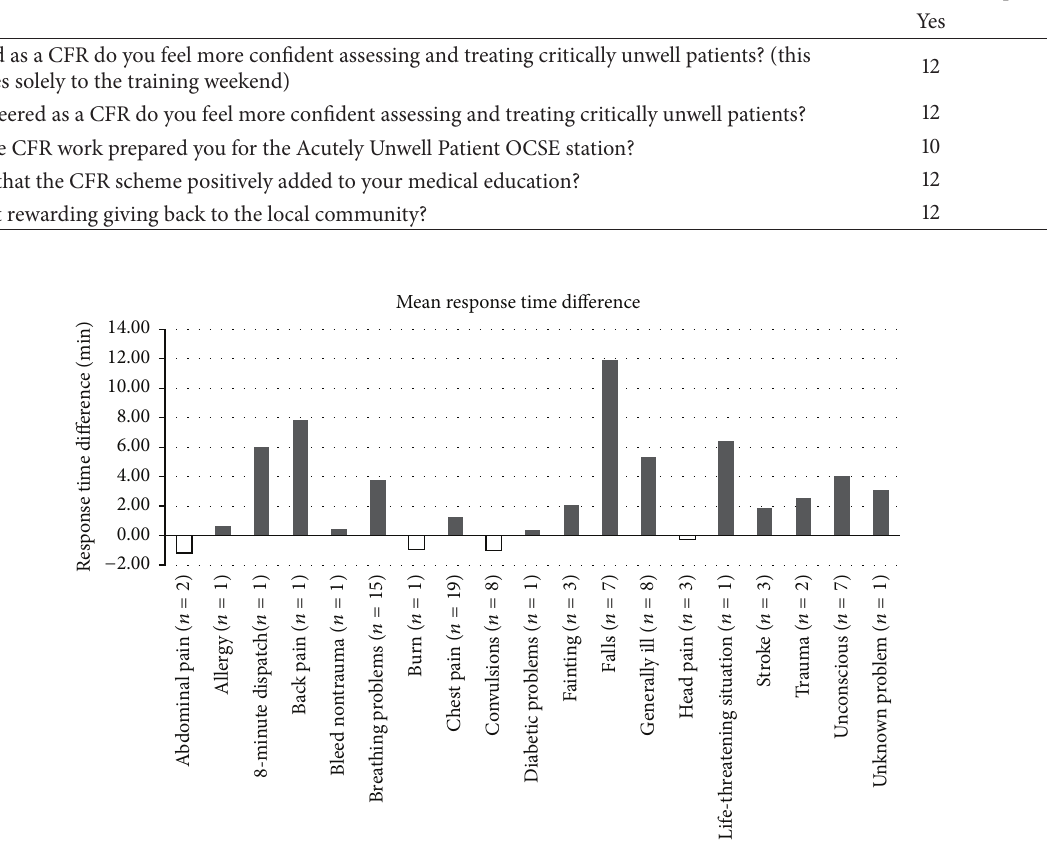
Figure 1: Mean response time difference, in minutes, between CFR and ambulance crews, separated by chief complaint.